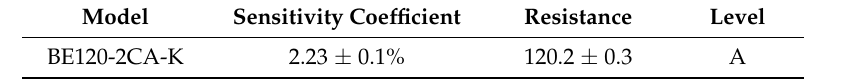
Table 6. Parameters of strain gauge for indentation method measurement system.